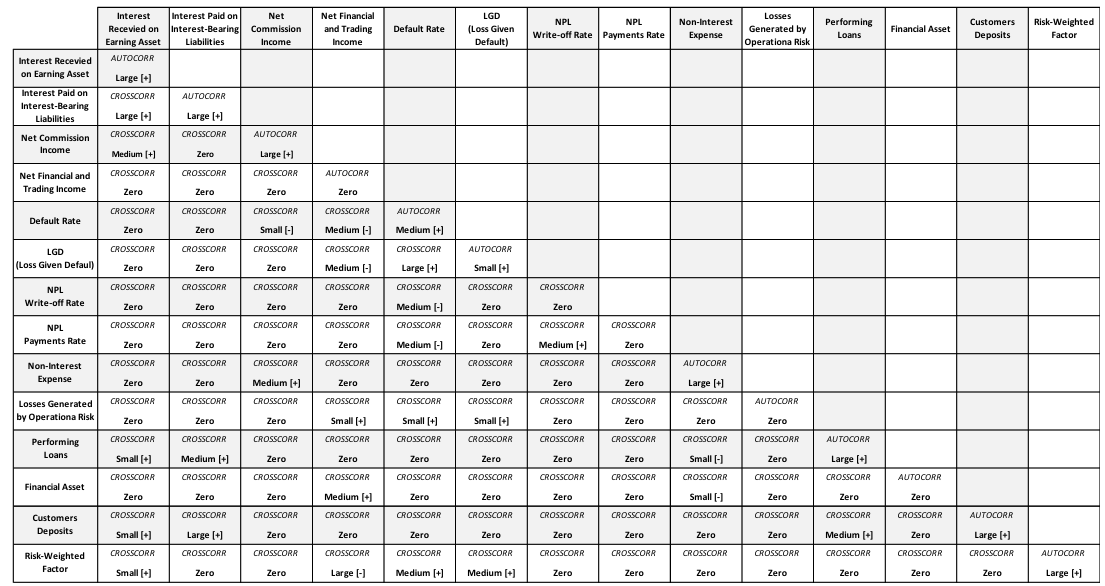
38 of 51 Figure A2. Deterministic variables: modeling & assumptions. Correlation Matrix: The Figure A3 below shows the Correlation Matrix assumptions adopted. Most of the correlation coefficients are based on historical cross-section empirical analysis, derived from